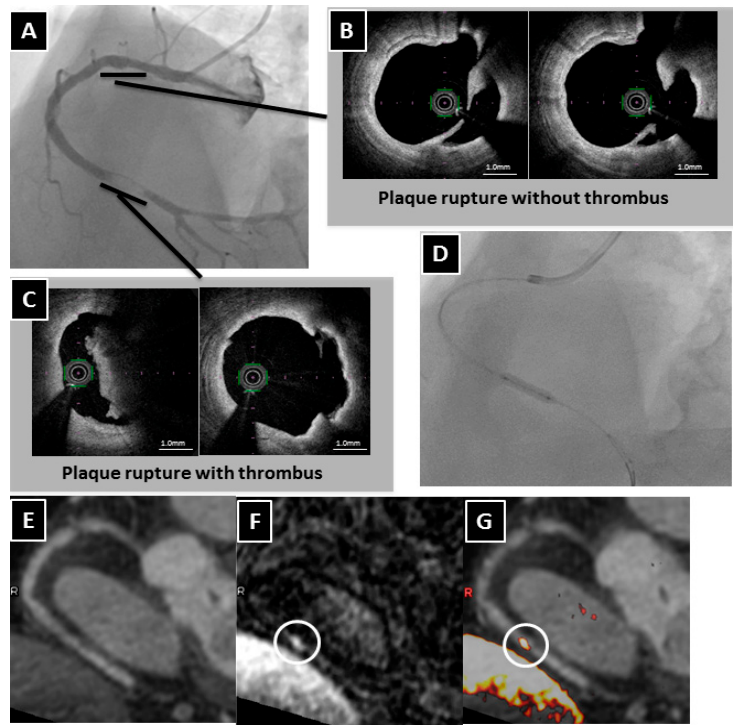
Figure 1. A representative case of a HIS lesion on T1WI associated with an intraluminal thrombus. ( A ) Coronary angiography revealing an intracoronary thrombus identified by the presence of intraluminal filling defects surrounded by contrast agents in the distal right coronary artery (RCA) and an ulceration in the proximal RCA; ( B ) The OCT examination showing a plaque rupture without a thrombus in the proximal RCA; ( C ) In contrast, the culprit lesion in the distal RCA with a plaque rupture with a large intracoronary thrombus; ( D ) Thrombus aspiration and plain old balloon angioplasty (POBA) performed on the culprit lesion; ( E ) Two days later after POBA, whole-heart coronary MR angiography revealing no significant stenosis in the distal RCA; ( F ) Coronary T1WI demonstrating intraluminal HIS on the culprit lesion (circle). However, there is no HIS at the ulceration of the proximal RCA; ( G ) Fused image showing intraluminal HIS in the area corresponding to the culprit lesion (circle). R in panels E–G indicates right side.